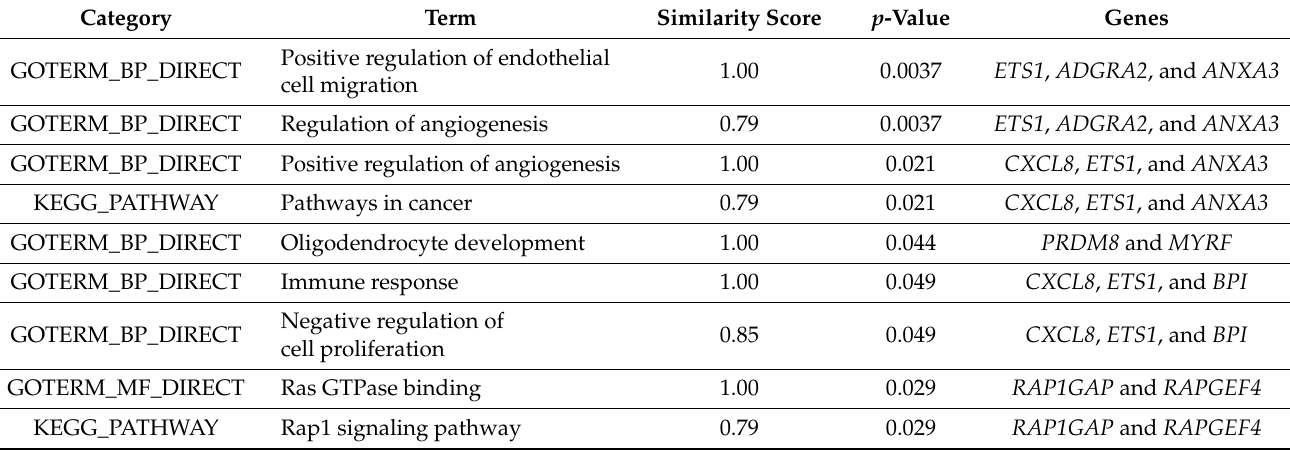
Table 2. Biological process and molecular function of upregulated genes effected by TQ